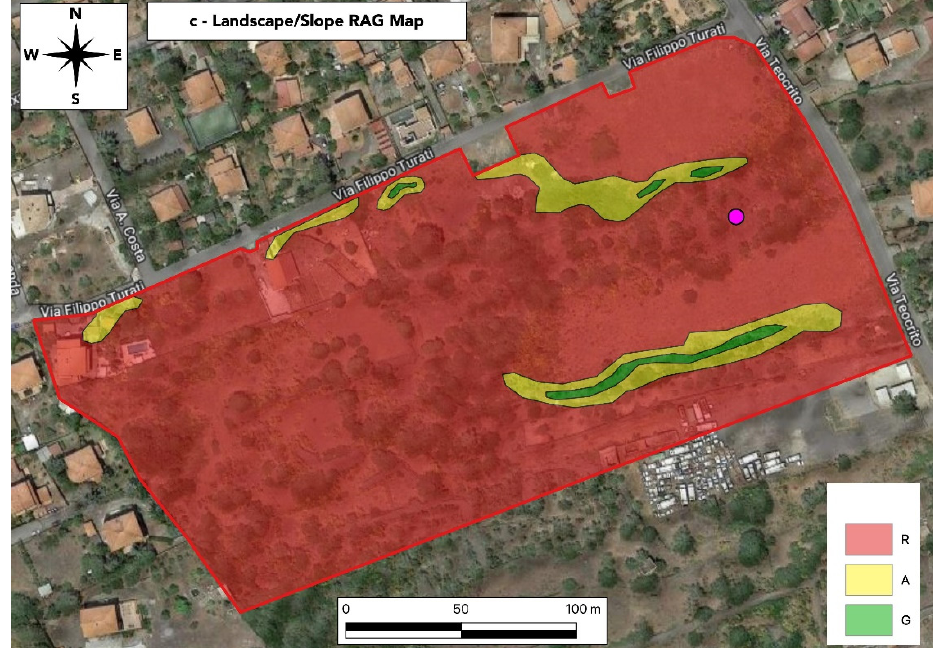
Figure 14. RAG map of the “Landscape/Slope” layer of the GIS platform. The burial site (pink circle) fell on the Red coded area. For the percentages of RAG color-coded areas see Figure 11.